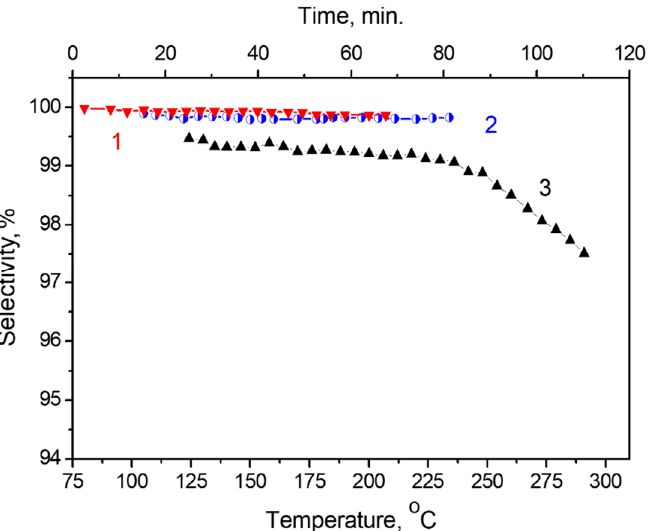
Figure 13. Dependence of the selectivity in the FA decomposition to hydrogen and CO 2 on temperature Pt/N-graphene catalysts synthesized using H 2 PtCl 6 as the precursor: 1% Pt/N-graphene (H 2 PtCl 6 ) (1); 0.4% Pt/N-graphene (H 2 PtCl 6 ) (2); 0.2% Pt/N-graphene (H 2 PtCl 6 ) (3). The selectivity of 0.2% Pt/N-graphene varied from 99.5% at 120 °C to 97.5% at 290 °C